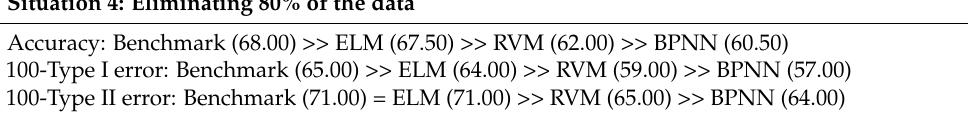
Table 10. Cont. Situation 4: Eliminating 80% of the data Accuracy: Benchmark (68.00) >> ELM (67.50) >> RVM (62.00) >> BPNN